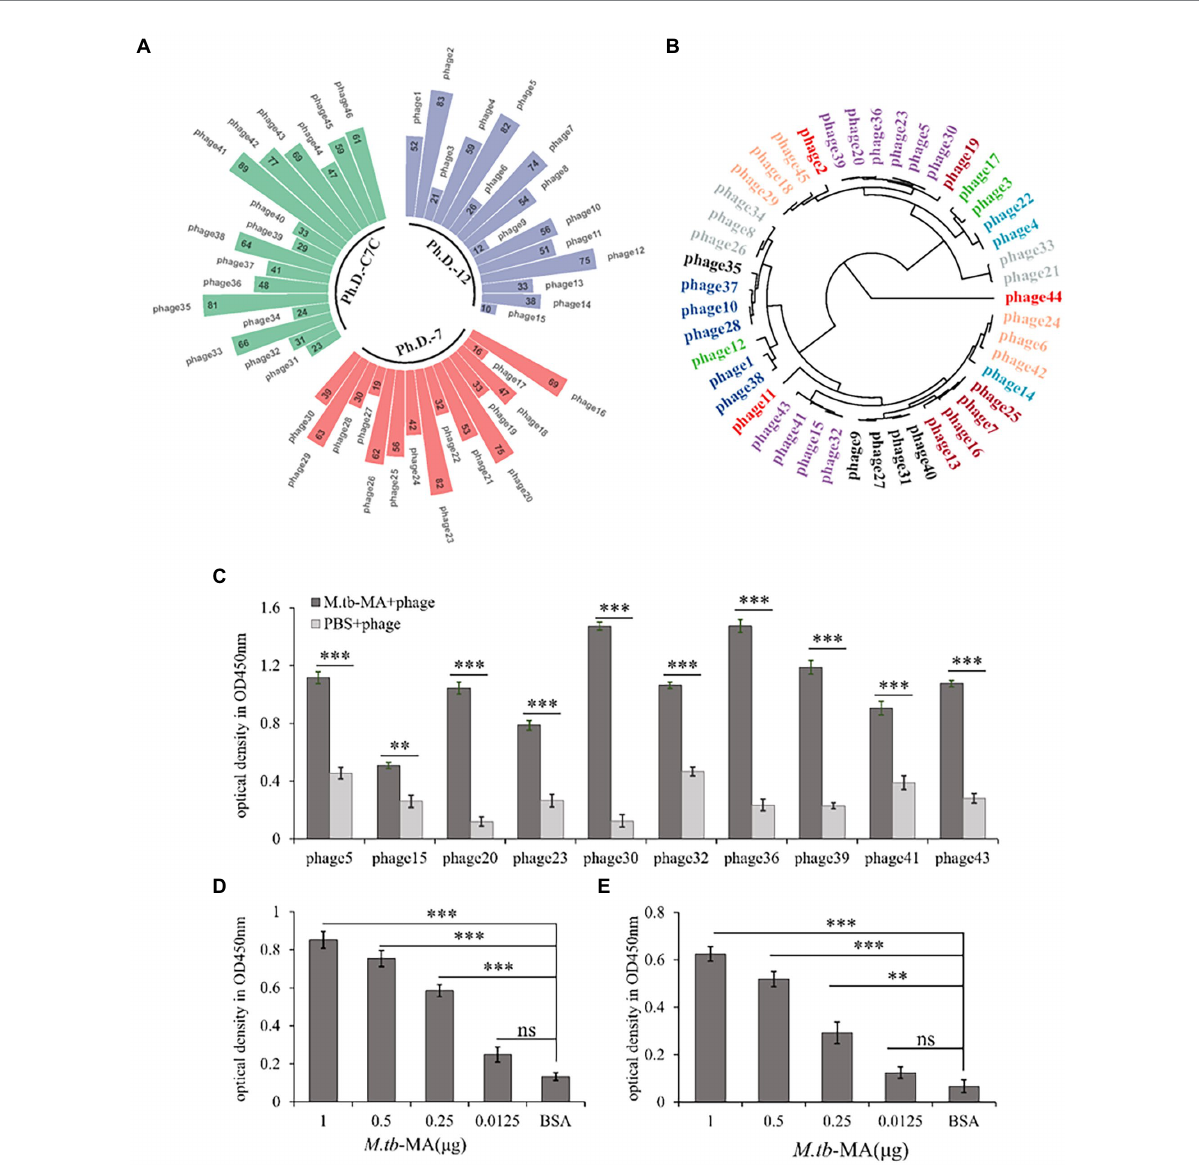
FIGURE 1 Generation and identification of M.tb -MA specific binding peptide. (A) M.tb -MA binding phage was obtained by screening different phage- displayed library shown in Nightingale rose chart. (B) Phylogenetic analysis of amino acid sequences of positive and higher binding phage. The tree was constructed using the neighbor-joining method; bootstrap of 1,000 replication (MEGAX). (C) 15 positive and higher binding phage clones panned by M.tb -MA were identified by ELISA ( n = 3). (D) The binding of phages expressing APTX4870 peptide to M.tb -MA was tested via phage ELISA. Phages expressing APTX4870 were added to ELISA plates coated with BSA (negative control) and M.tb -MA (1, 0.5, 0.25, and 0.125 μ g/well). Bound phages were detected using HRP-conjugated 9E10, and visualized with 3,3 ′ ,5,5 ′ -tetramethylbenzidine (TMB). Absorbance was measured at 450 nm ( n = 3). (E) His tag-conjugated APTX4870 was added to ELISA plates coated with M.tb -MA (1, 0.5, 0.25, and 0.125 μ g/well). Bound APTX4870 was detected using HRP-conjugated anti-His tag antibody and visualized with TMB ( n = 3). ** 0.01 < p < 0.05; *** p <